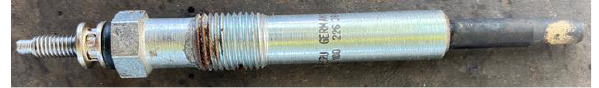
Fig. 3. The glow plug failure resulted from a melting of its heating part for the glow plug used in the 2008 Ford Focus 1.8 tdci engine. Source: own elaboration